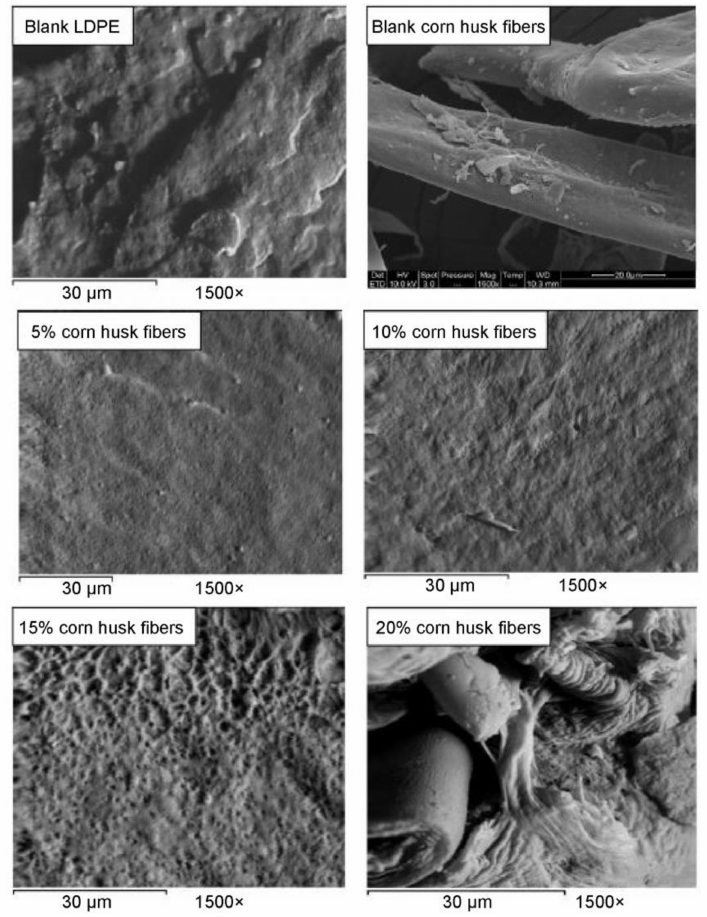
Figure 5. Scanning electron microscopy (SEM) micrographs of composites based on PE and corn husk fibers. Content of corn husk fibers in composites varies from 0–20%. Adapted from Ahmed Youssef et al.